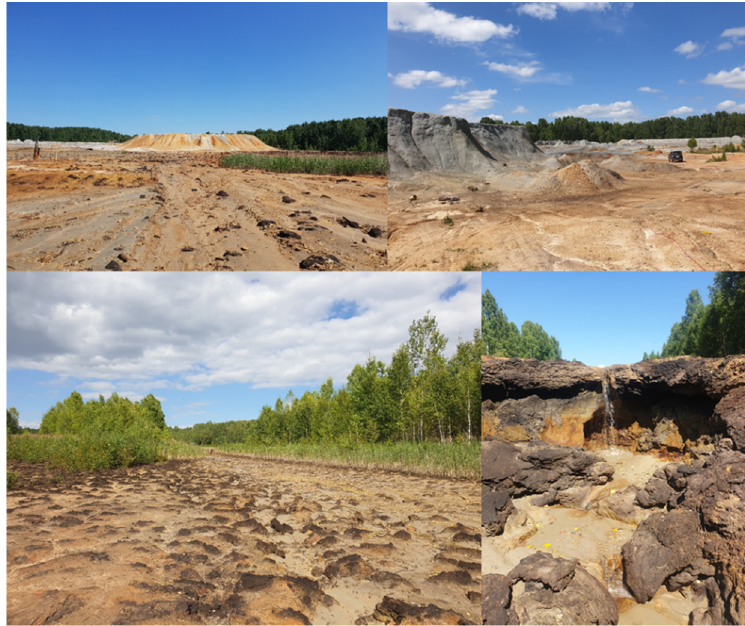
Figure 2. Photos of the Ursk dump, the drainage valley, and the “manmade